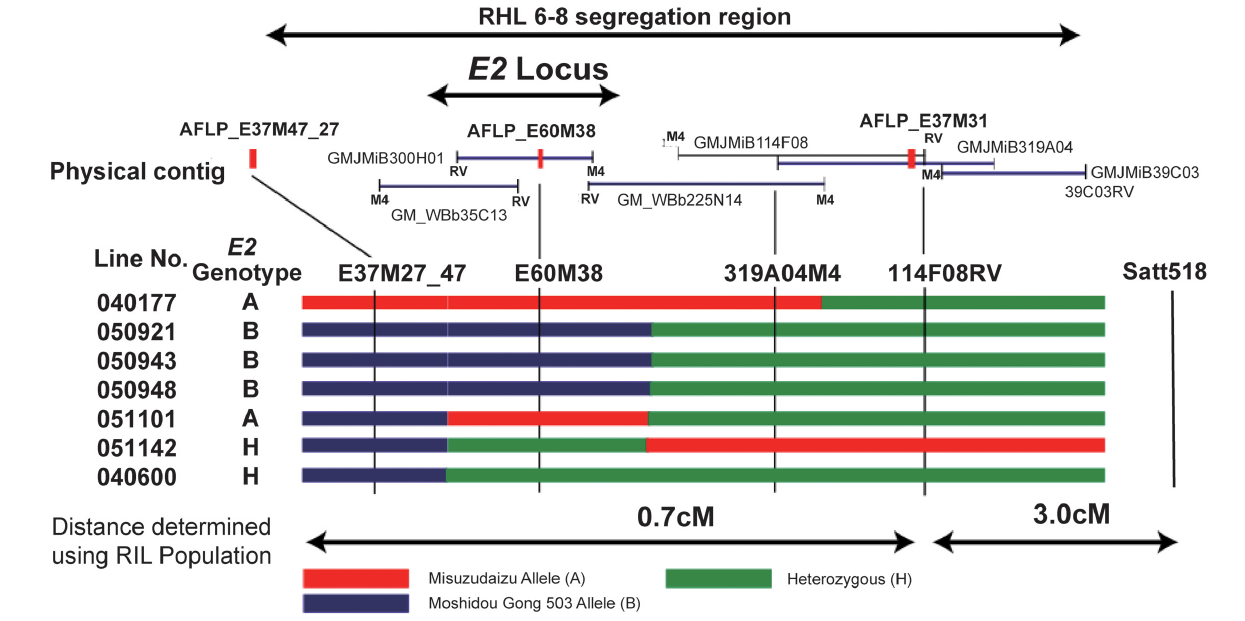
Frontiers in Plant Science |